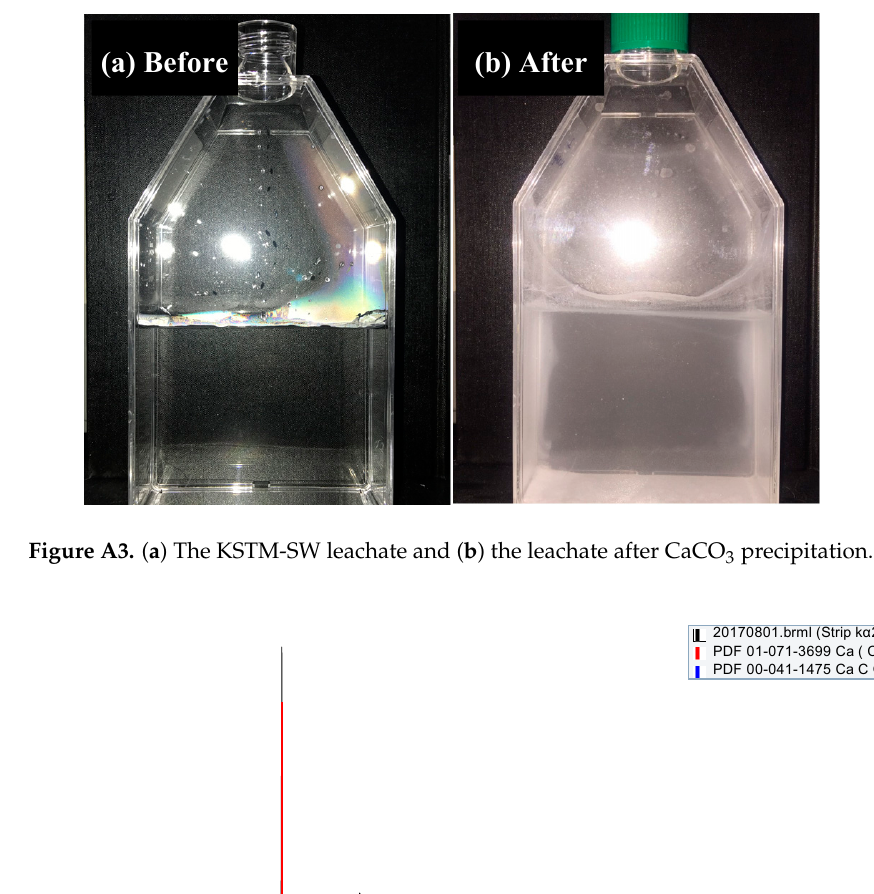
Figure A2. Peak patterns of the mine tailings, red mud, waste limestone, and lightweight aggregate determined using X–ray diffraction (XRD).